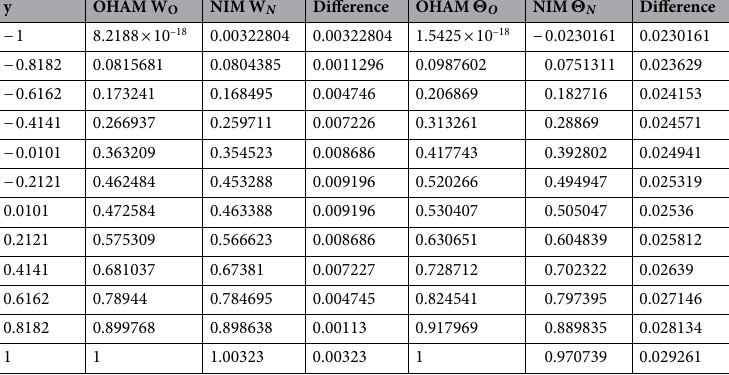
Table 6. For (cid:31) = 0.2, M = 0.001, B = 0.9 and A = 0.2. .